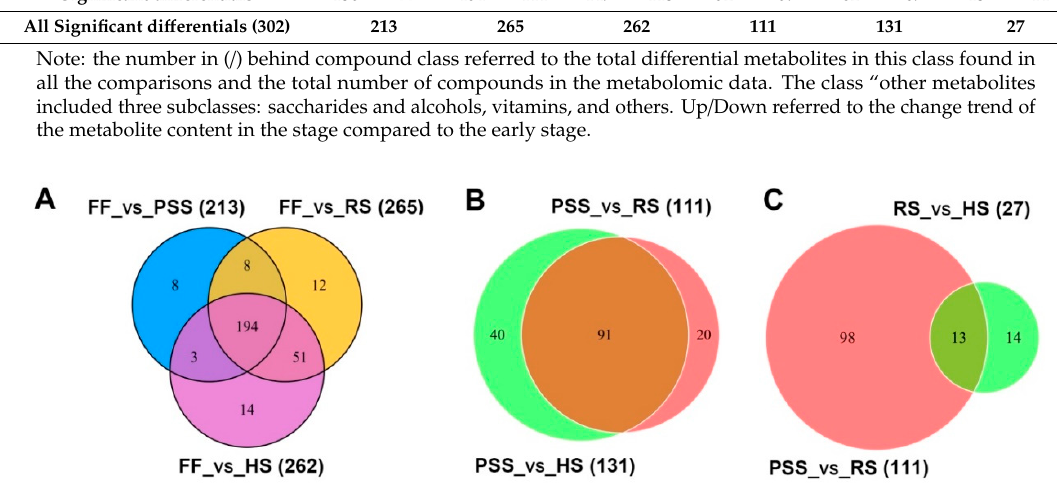
Figure 5. Venn diagrams showing differential metabolites shared or unique among the different comparisons. ( A ) Differential metabolites detected by comparisons of FF stage and the remaining three growth stages. ( B ) Differential metabolites detected by comparisons of PSS stage and its subsequent two stages. ( C ) differential metabolites detected by comparisons of RS stage and its two neighboring stages: PSS and HS stages. The number in () was the altered metabolites between two compared growth stages. The numerical values on the Venn diagram depicted the number of differential metabolites shared or unique among the different comparisons. The abbreviated stage name and observation dates were the same as described in Figure 3.